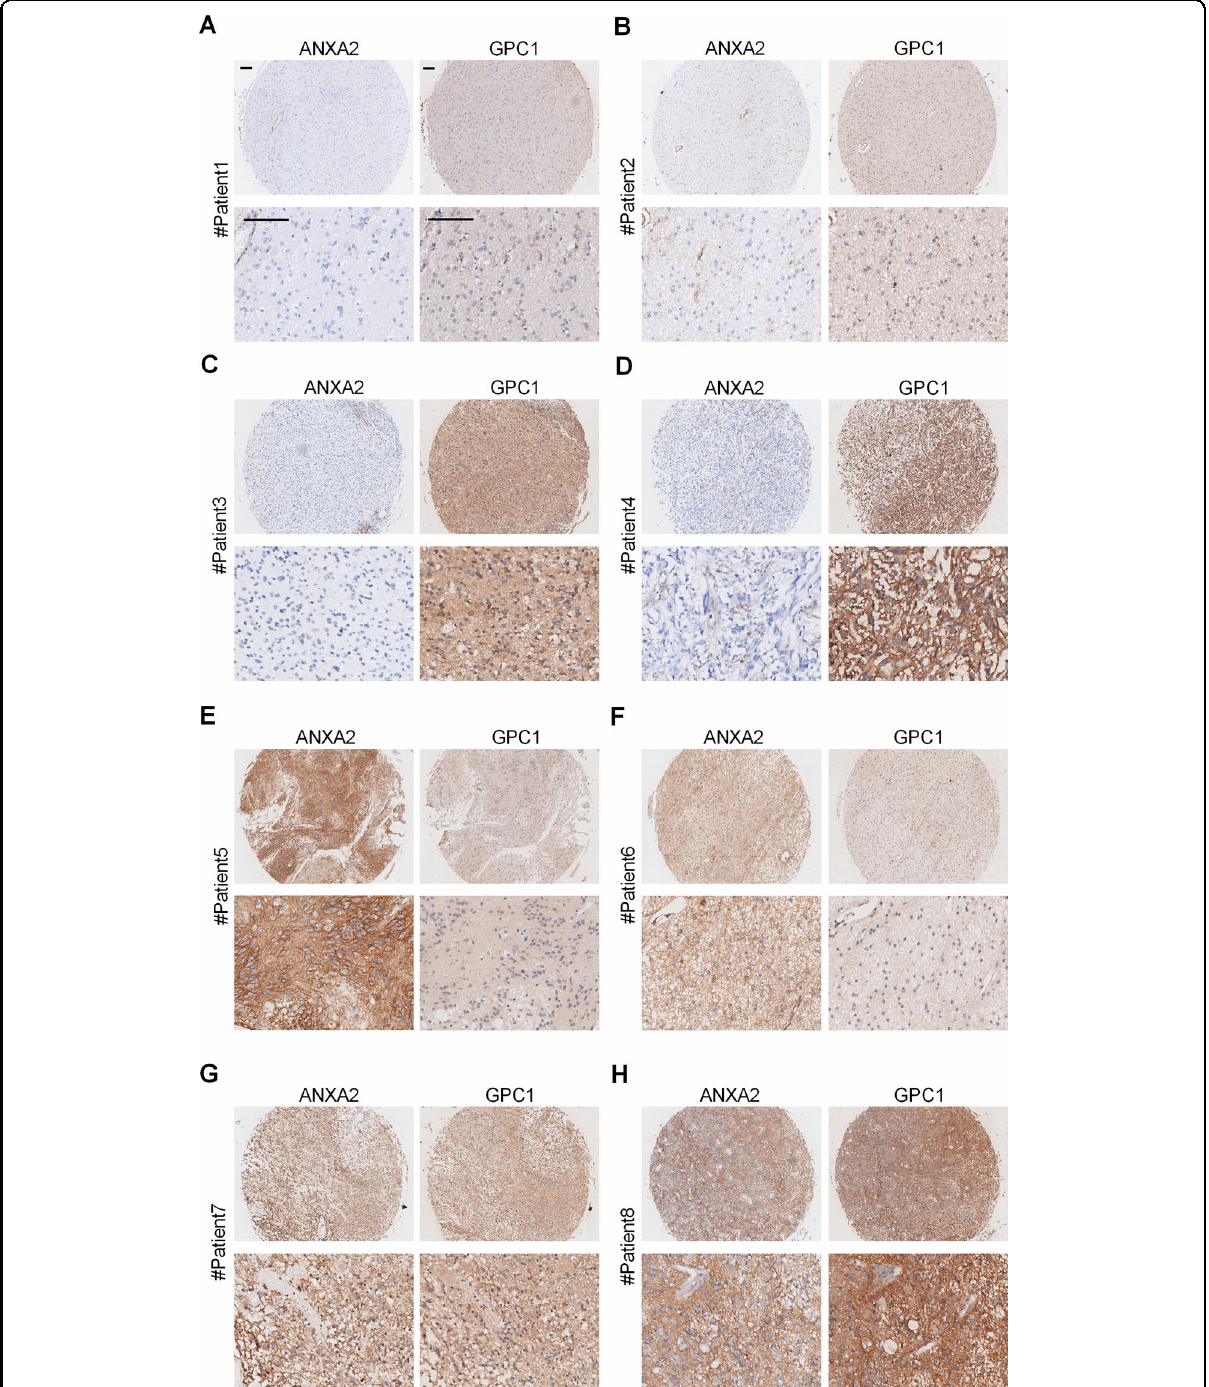
Fig. 4 Expression patterns of ANXA2 and GPC1 in glioma samples. A – H Representative glioma samples show that the expression of ANXA2 (left panel) and GPC1 (right panel) is diverse. A , B Low expression of both ANXA2 and GPC1. C , D Low expression of ANXA2 and high expression of GPC1. E , F High expression of ANXA2 and low expression of GPC1. G , H High expression of both ANXA2 and GPC1. Scale bar = 50 μ